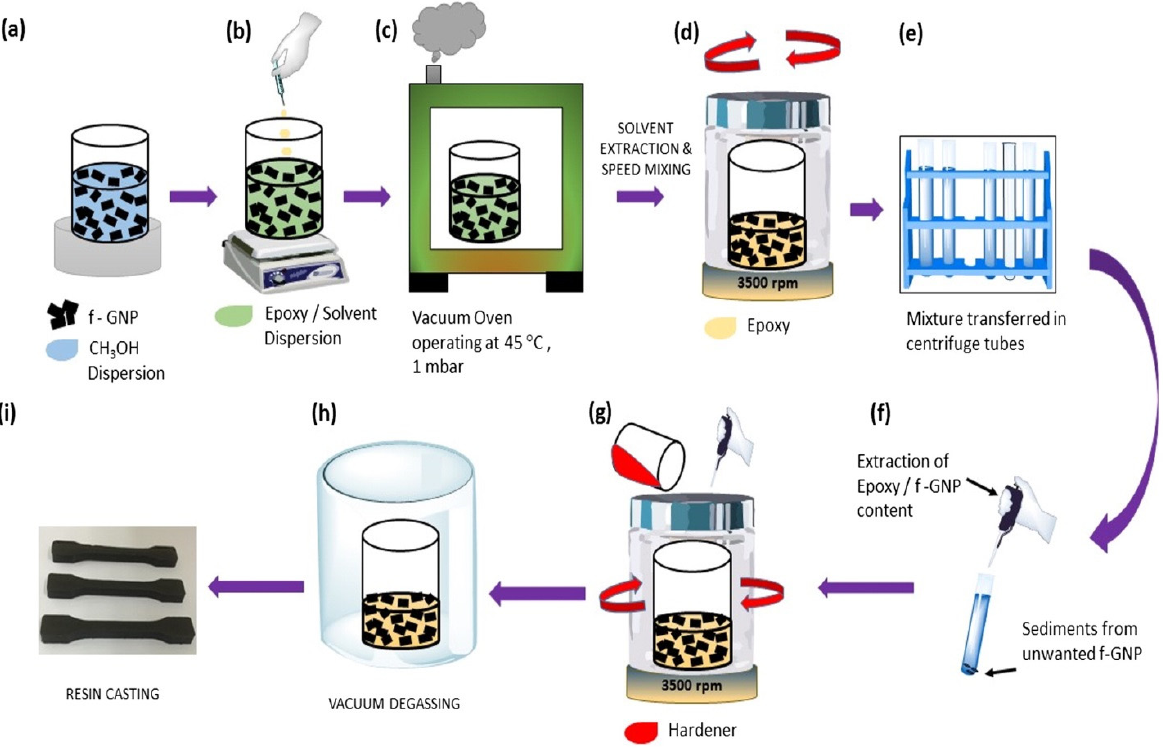
Figure 3. Schematic of the dispersion ( a ) to application ( i ) process of conductive filler in nano-composite [31].